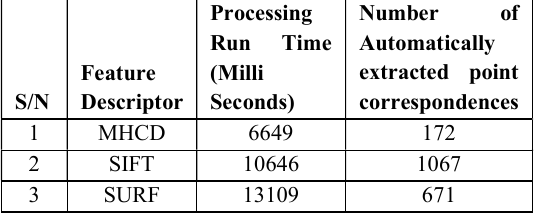
Table 3: Results of the selected three feature descriptors’ speed and number of extracted point